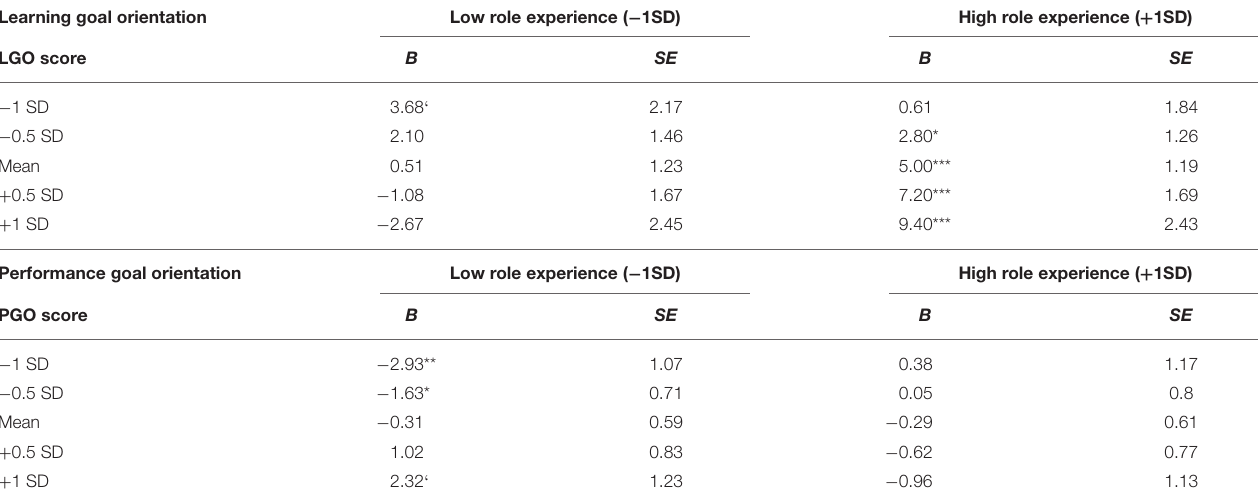
TABLE 5 | Marginal effects of top decision makers’ goal orientations, moderated by role experience. Learning goal orientation